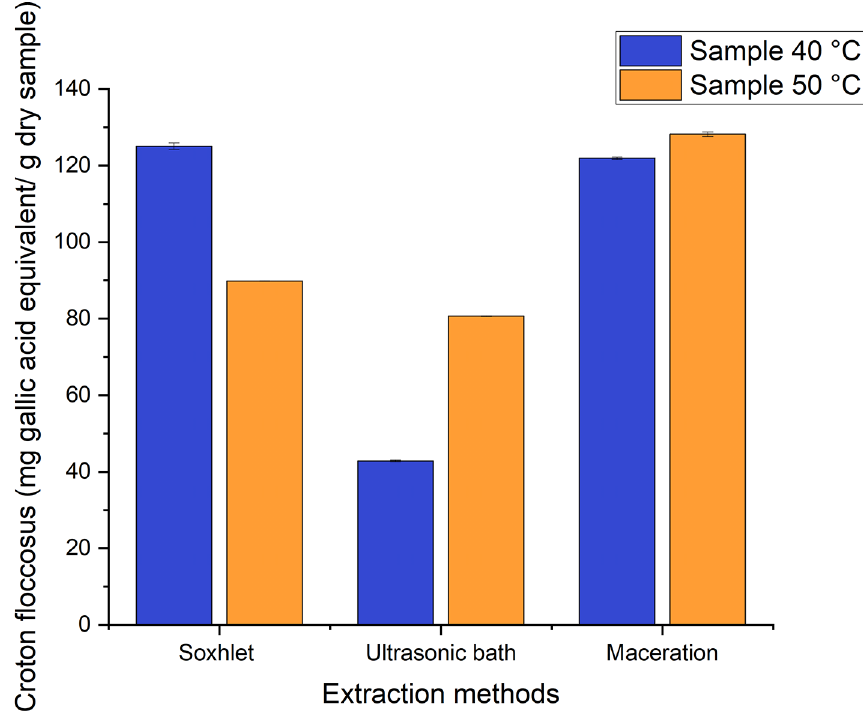
Figure 10. Phenolic content of the different ethanolic extracts of Croton floccosus.